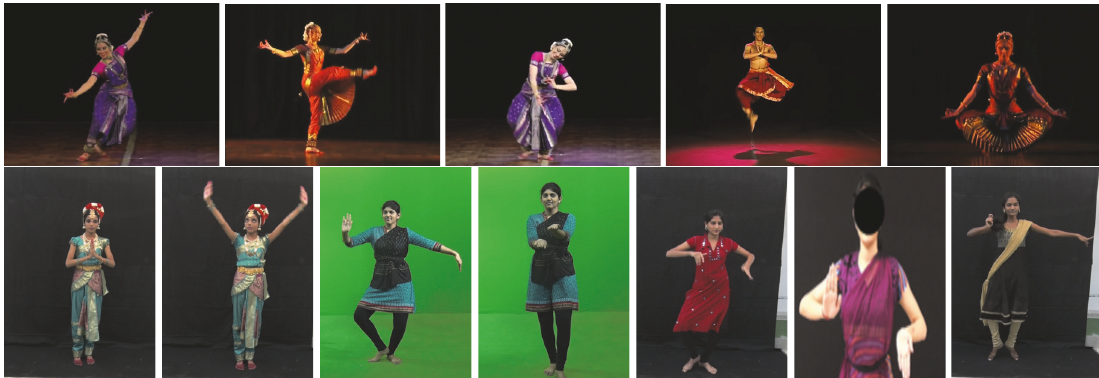
Figure 1: Sample Indian classical dance from online and offline datasets used in this